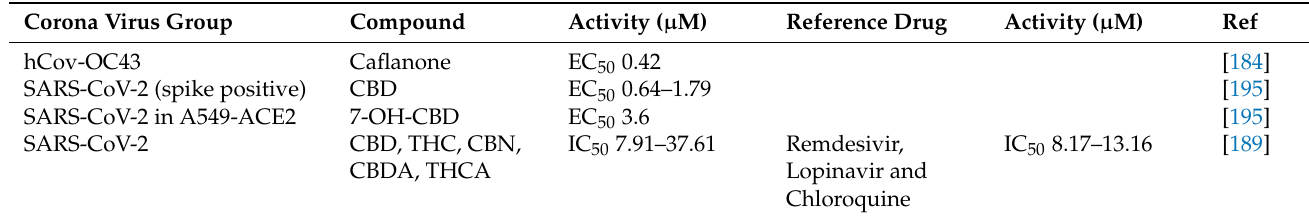
Table 5. Antiviral activity of cannabinoids against Corona